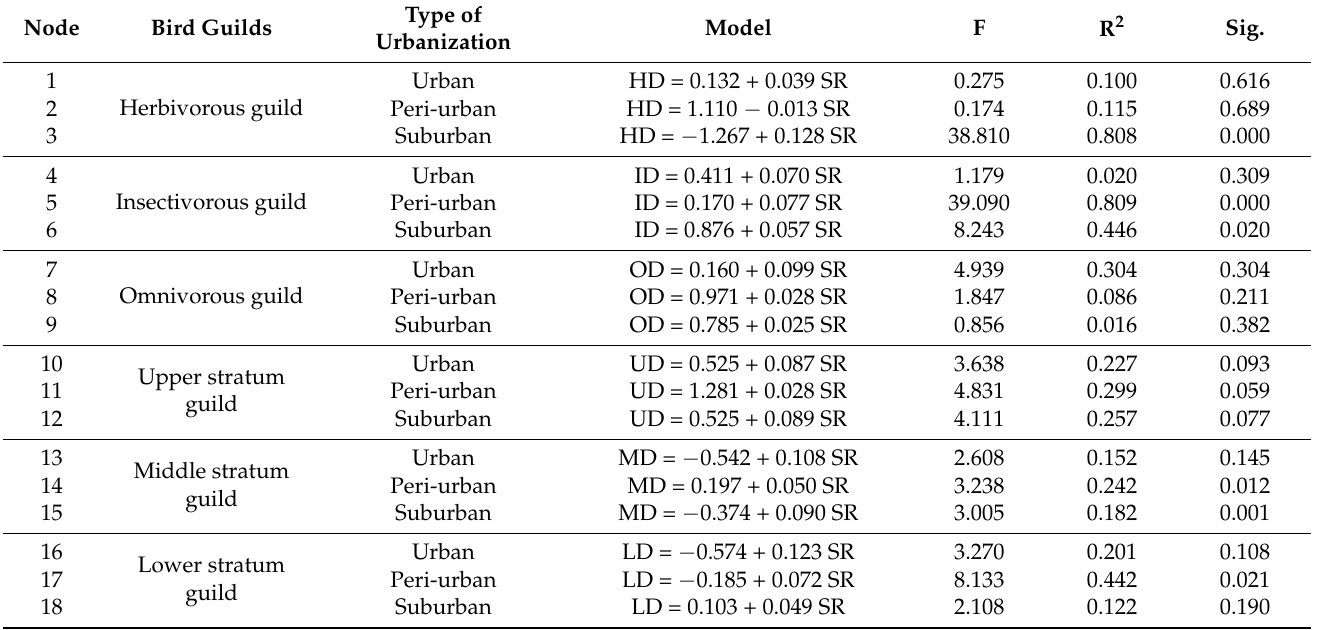
Table 3. The linear regression model showing the relationship between α -diversity and species richness of bird functional groups in mountain parks under different urbanization types. The meanings of each abbreviation in the table are as follows: HD means herbivorous α -diversity, ID means insectivorous α -diversity, OD means omnivorous α -diversity, UD means upper sub-stratum α -diversity, MD means middle sub-stratum α -diversity, LD means lower sub-stratum α -diversity, SR means species